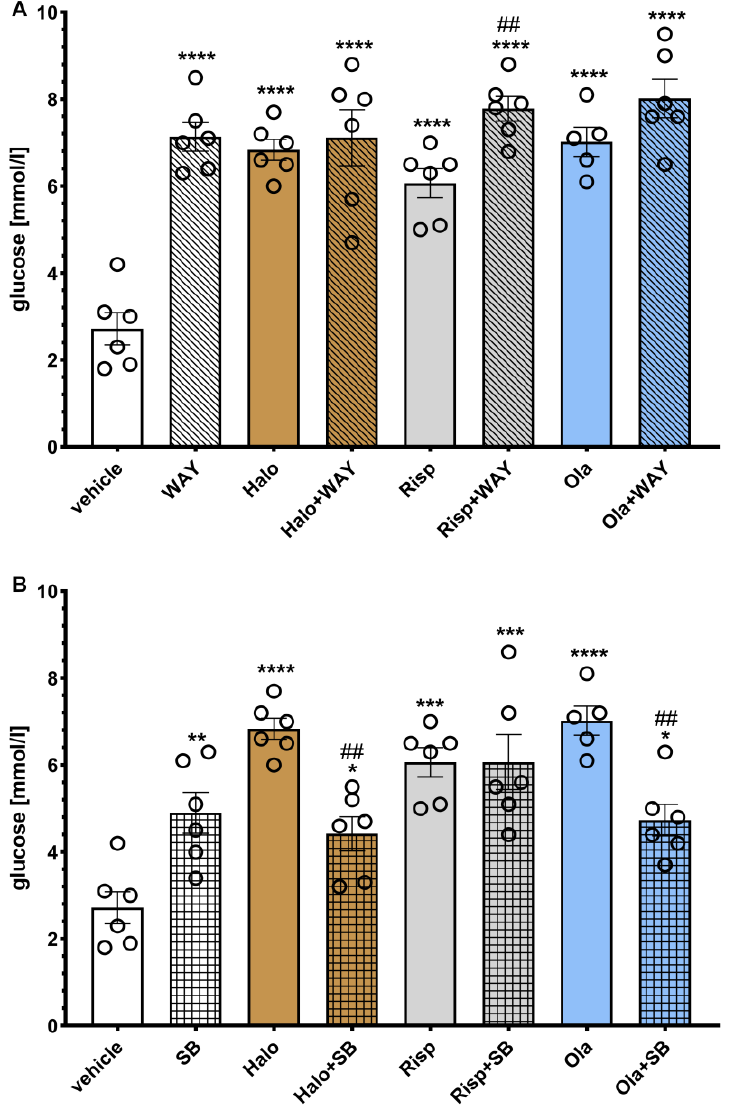
Figure 6. Effects of haloperidol, risperidone, olanzapine, WAY-181187 ( A ) and SB-742457 ( B ), administered alone and in combinations, on the glucose level in rat serum. The results are presented as mean ± SEM; n = 5–6. * p < 0.05, ** p < 0.01, *** p < 0.001, **** p < 0.0001 versus respective vehicle-treated group; ## p < 0.01 versus the respective APD-treated group (two-way ANOVA followed by Bonferroni’s post hoc test). Halo, haloperidol 0.5 mg/kg; Risp, risperidone 0.5 mg/kg; Ola, olanzap-